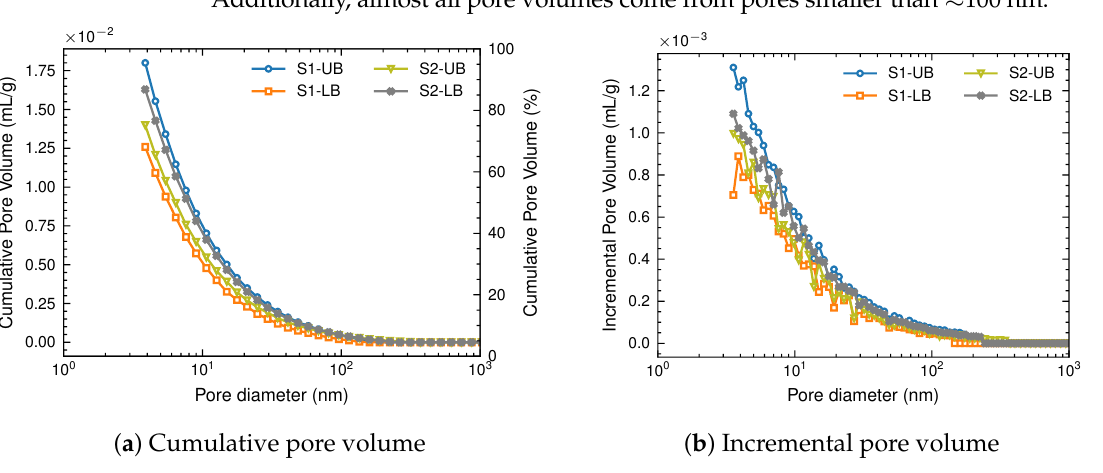
Figure 4. Pore throat size distribution data from